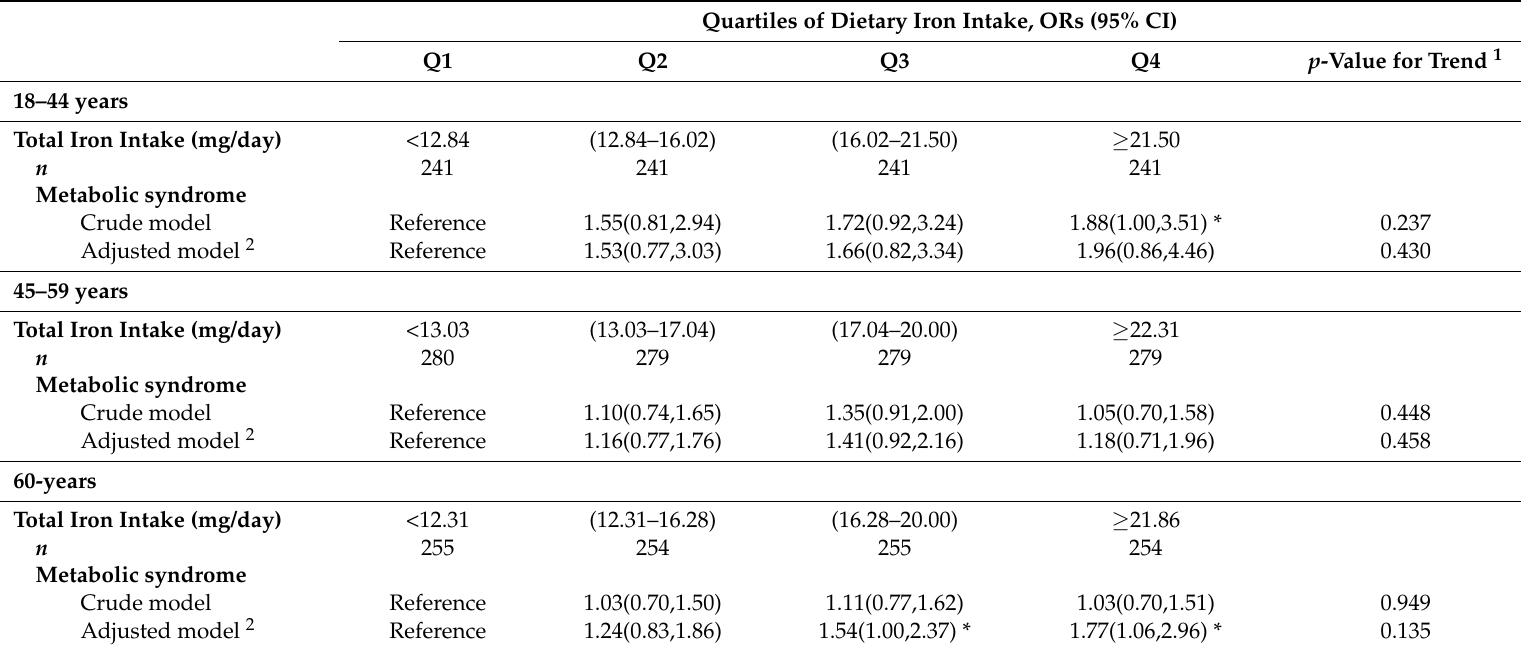
Table A1. ORs (95% CI) for metabolic syndrome according to the quartiles of total iron intake (mg/day) by age group in the SDHS